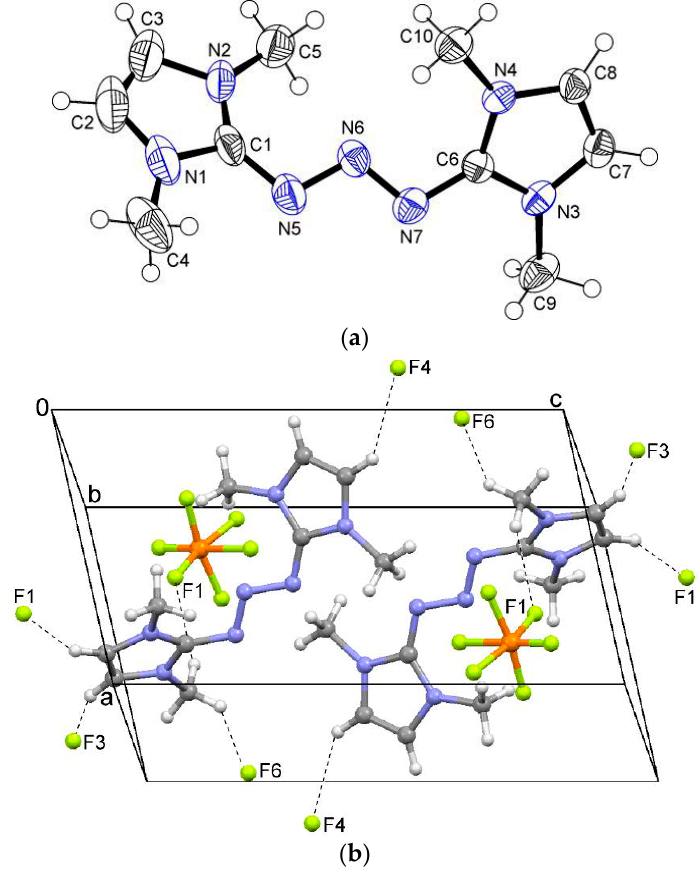
Figure 2. ( a ) Molecular structure of the cation; ( b ) interactions in the crystal structure of 1